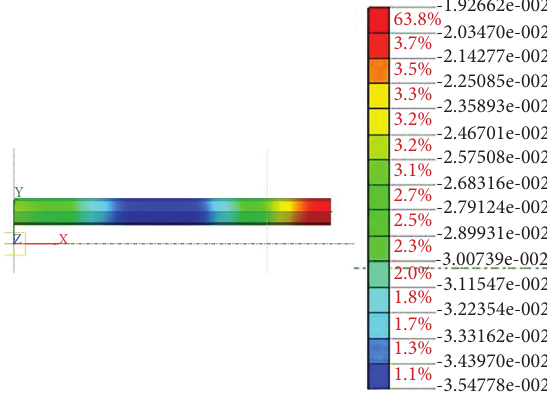
Figure 7: Pipeline deformation cloud map.